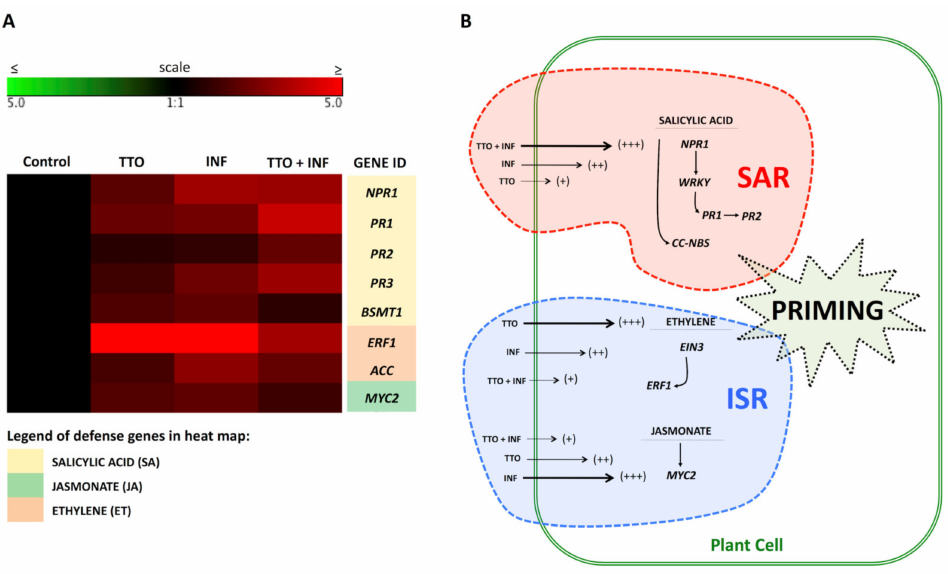
Figure 3. TTO induces systemic resistance to Fusarium oxysporum f. sp. cubense (Foc) in banana plants via SAR and ISR pathways. ( A )—Gene expression in banana plants infected with Foc. The heat map illustrates the doubled changes in gene expression (log2 scale) in samples collected 15 days after the application of TTO. Di ff erent shades represent induced or repressed gene expression. Biological and technical triplicates were used in the analysis. Gene acronyms are listed in the right column. The defense routes are indicated by colors according to the legend. ( B )—Scheme illustrating regulation of salicylic acid, ethylene and jasmonate pathways in the plant cell. Arrow sizes and scores ( +++ ; ++ ; + ) indicate the intensity of expression of genes related to SAR and ISR